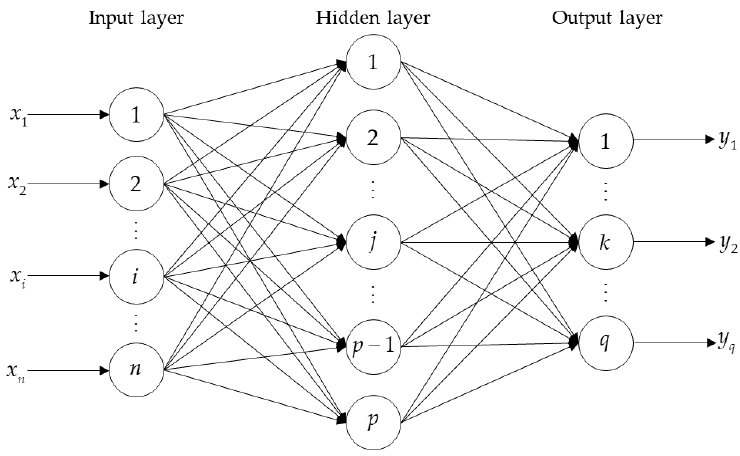
Figure 3. Structure of the back propagation neural network (BPNN).